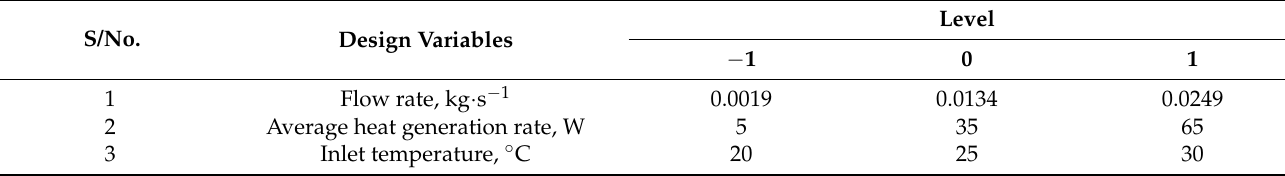
Table 1. Design variables and levels of the condition.